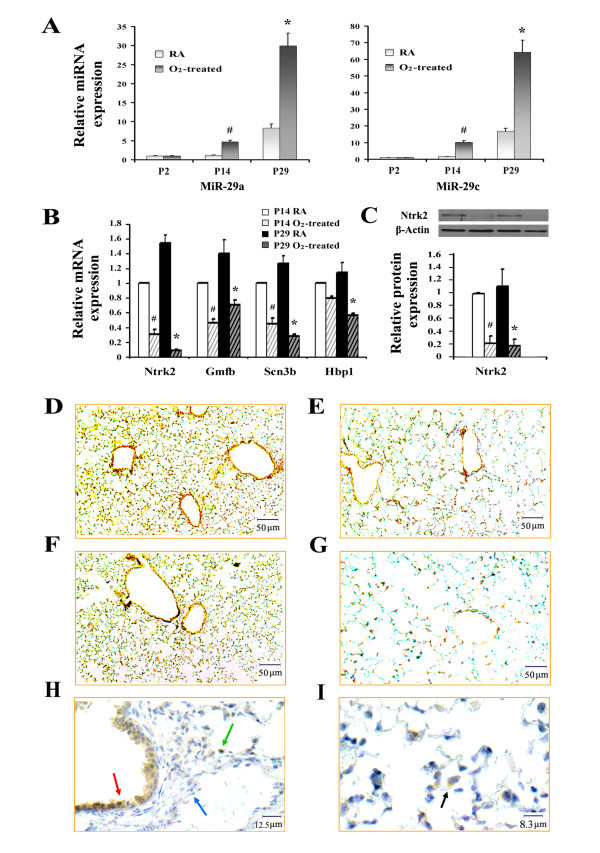
Effects of hyperoxia on the expression of miR-29 and predicted mRNA targets. (A) Relative expression of miR-29a and miR-29c (n = 3, mean ± SE, # p < 0.05 vs. P14 room air controls, * p < 0.05 vs. P29 room air controls). (B) Relative mRNA expression by RT-PCR comparing mouse lung exposed to room air with hyperoxia (n = 3, mean ± SE, # p < 0.05 vs. P14 room air controls, * p < 0.05 vs. P29 room air controls). (C) Nrtk2 protein expression measured by Western blot analysis using β-actin as the loading control (n = 3, mean ± SE, # p < 0.05 vs. P14 room air controls, * p < 0.05 vs. P29 room air controls). Protein expression of Nrtk2 in the lung of P14-RA (D), P14-O2-treated (E), P29-RA (F) and P29-O2-treated mice (G). Nrtk2 immunoreactivity was detected in brown. (H) and (I) Immunohistochemical localization of Nrtk2 in P29-RA lung. Red arrow indicates bronchiolar epithelial cells, green arrow indicates type II pneumocyte, blue indicates endothelial cells and black indicates macrophage.